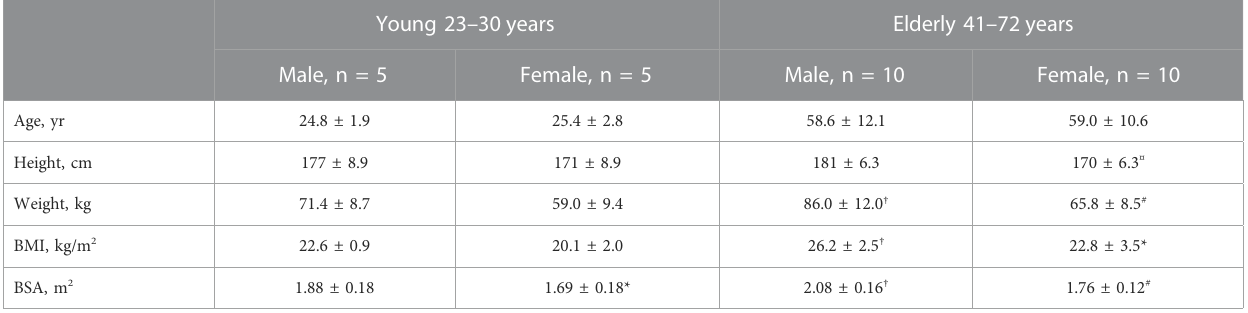
TABLE 2 Characteristics of the studied population.